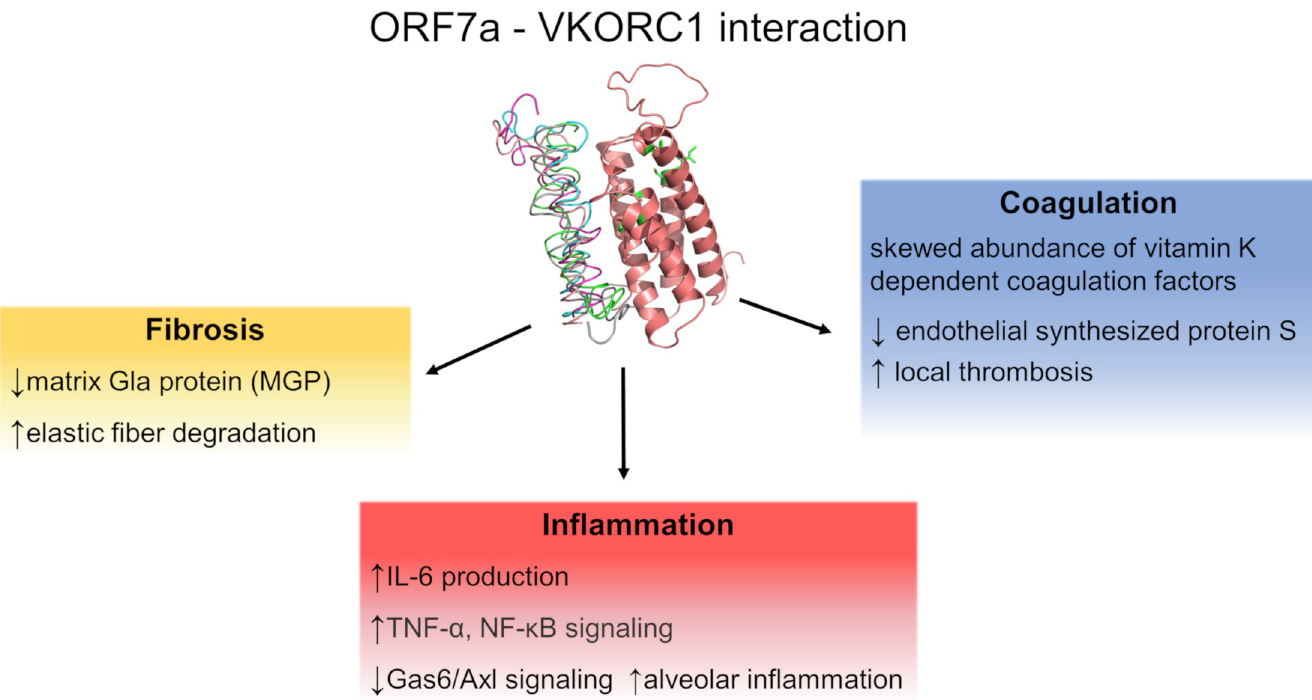
Fig 1. Graphic summary of ORF7a-VKORC1 interaction and possible effects. The interaction between ORF7a and VKORC1 and possible effects of this interaction.